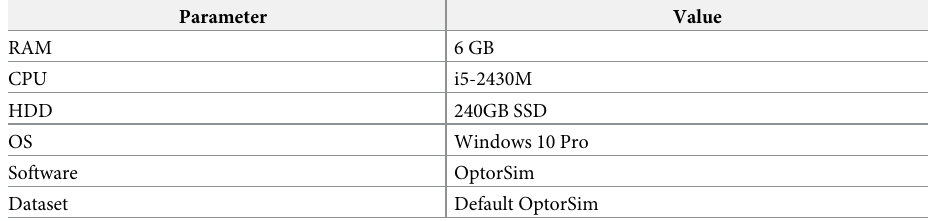
Table 2. System used for simulation.